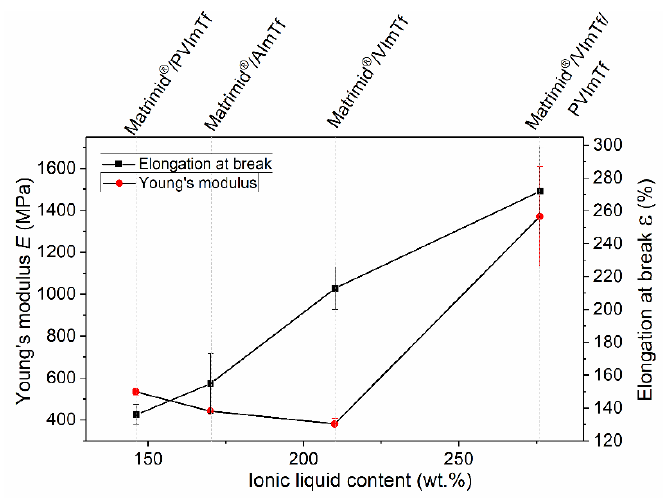
Figure 6. Thermogravimetrical curves of pure Matrimid ® and elaborated SILMs.